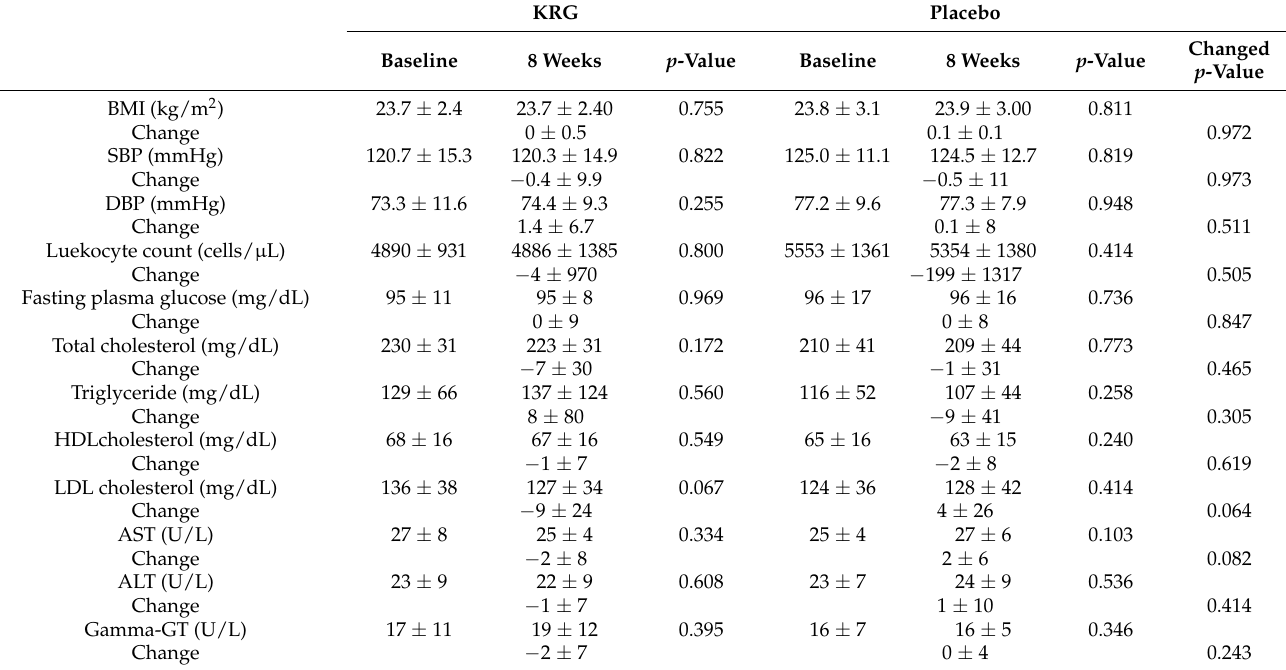
Table 2. Changes in metabolic parameters of the KRG and placebo groups before and after 8 weeks. KRG